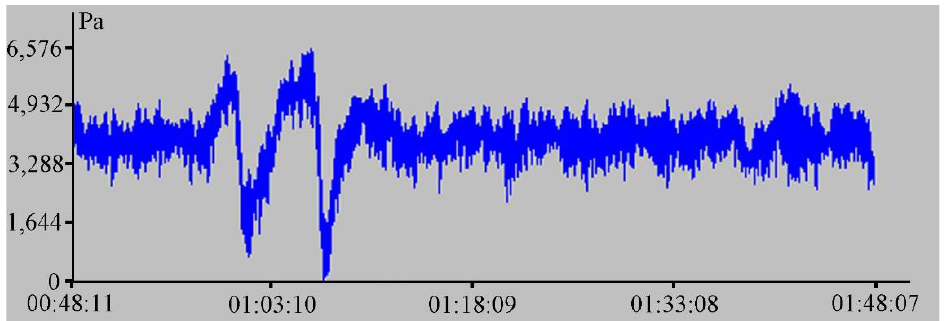
Figure 12. A recording section of the supersensitive detector of hydrosphere pressure variations for 3 June 2021 installed on the seabed at a depth of 27 m at Cape Shultz.